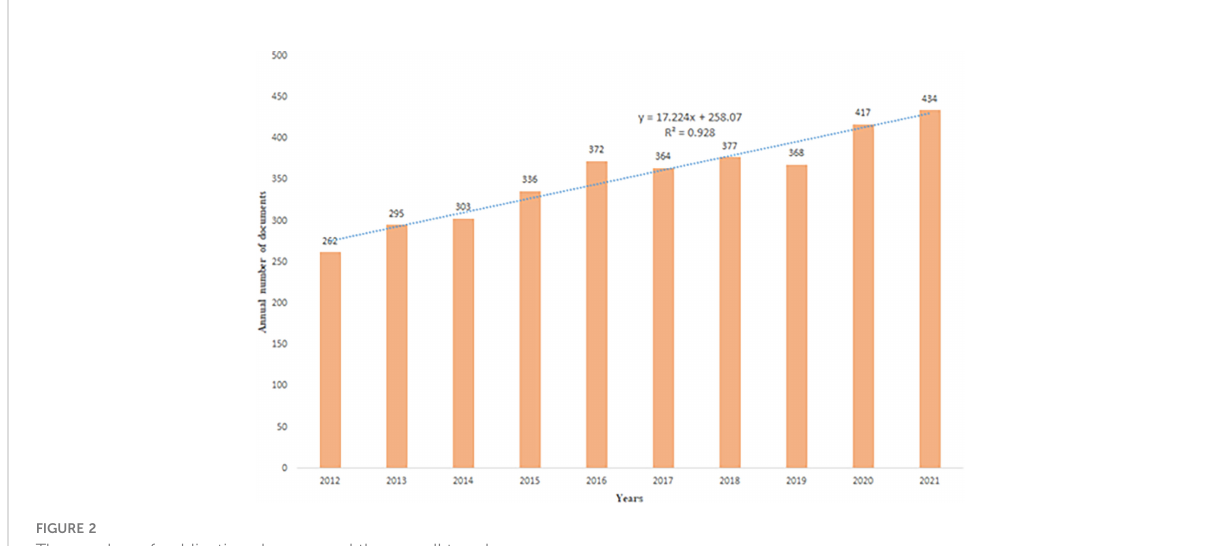
FIGURE 2 The number of publications by year and the overall